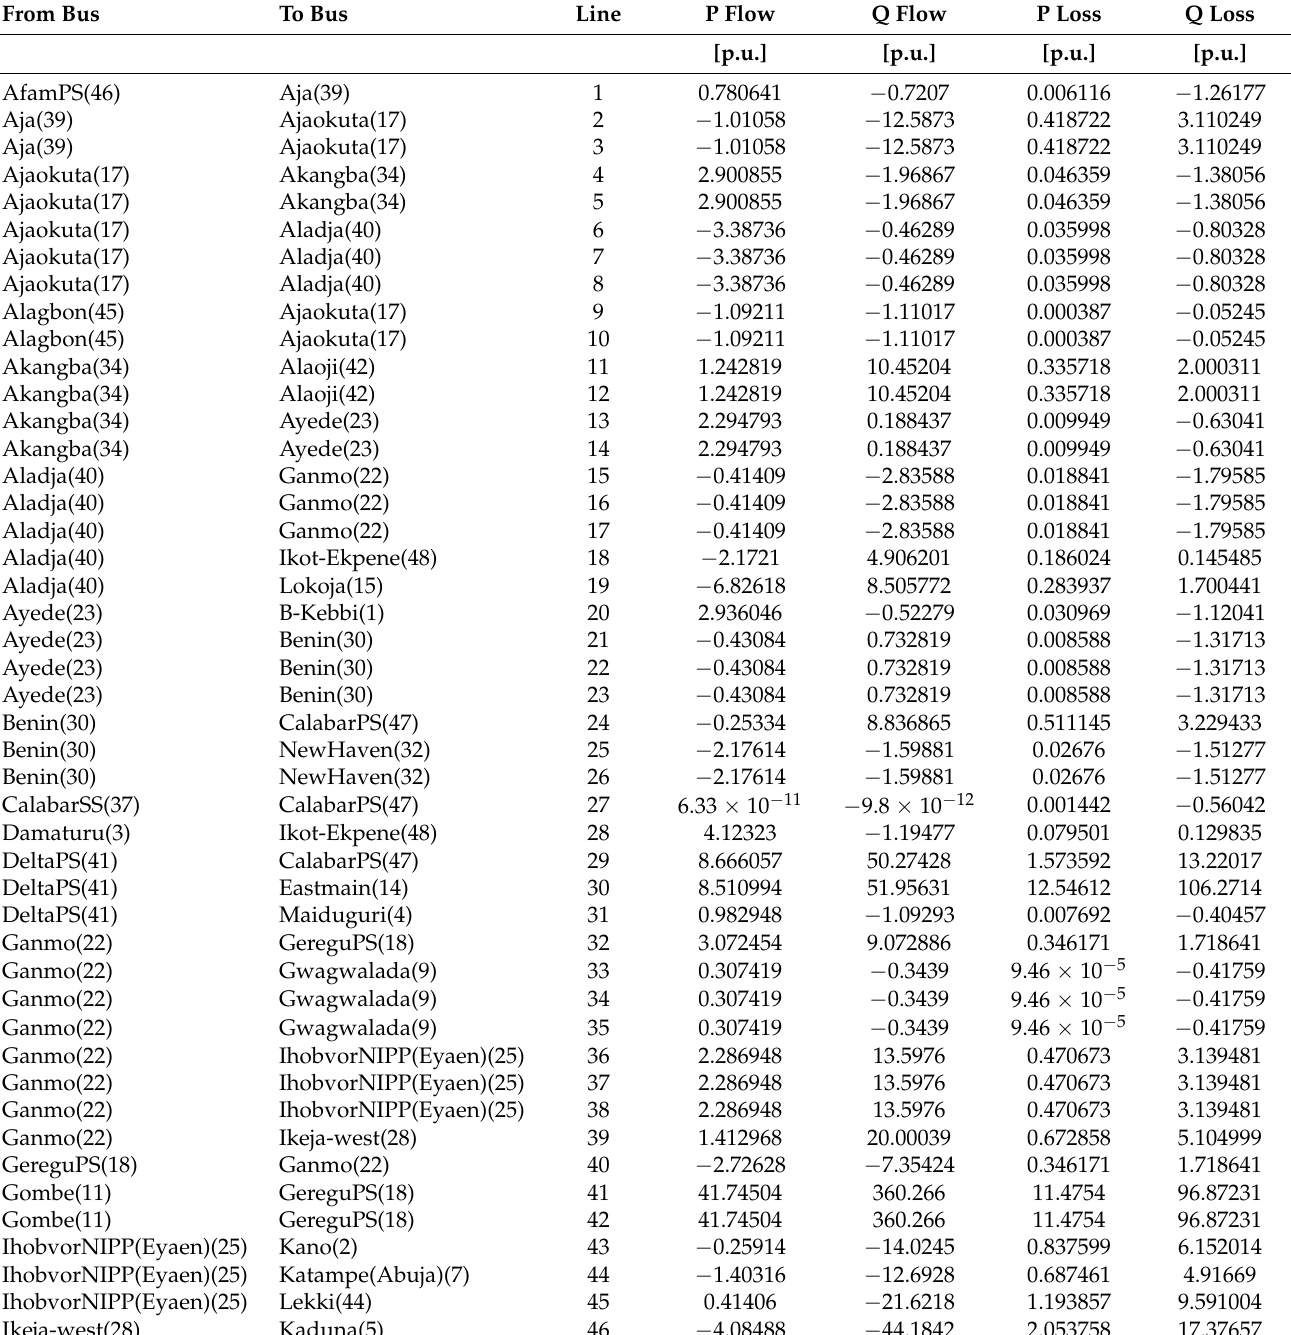
Table 2. Power flow result of the uncompensated Nigerian transmission